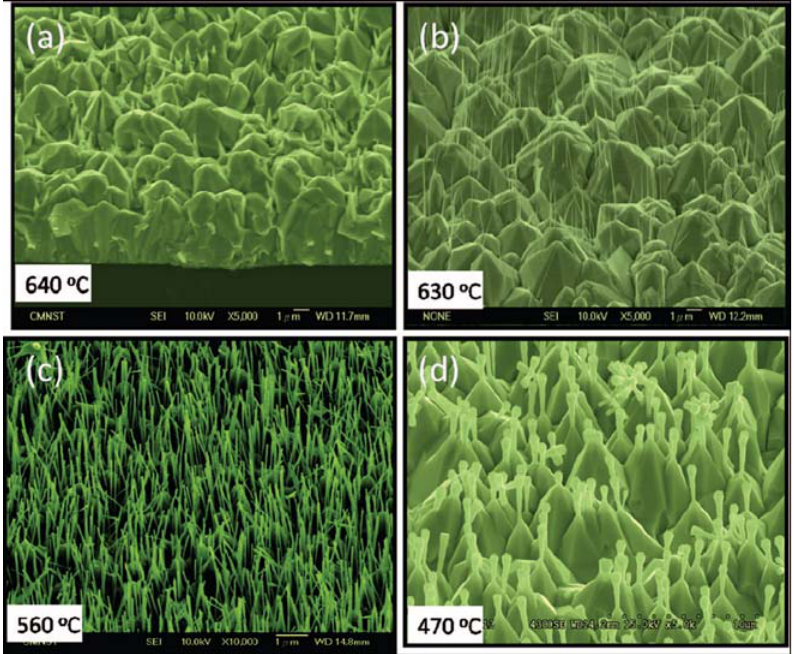
Figure 17. SEM images of samples A, B, C, and D grown at (a) 640, (b) 630, (c) 560 and (d) 470 °C, respectively. The magnifications are 5000 for a, b, and d and 10000 for c. Reprinted from Ref. [31] with